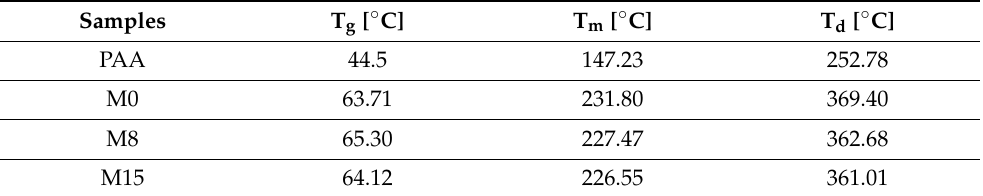
Table 3. Values of glass transition temperature (Tg), melting temperature (Tm), and degradation temperature (Td) of the CA and CA/PAA blended